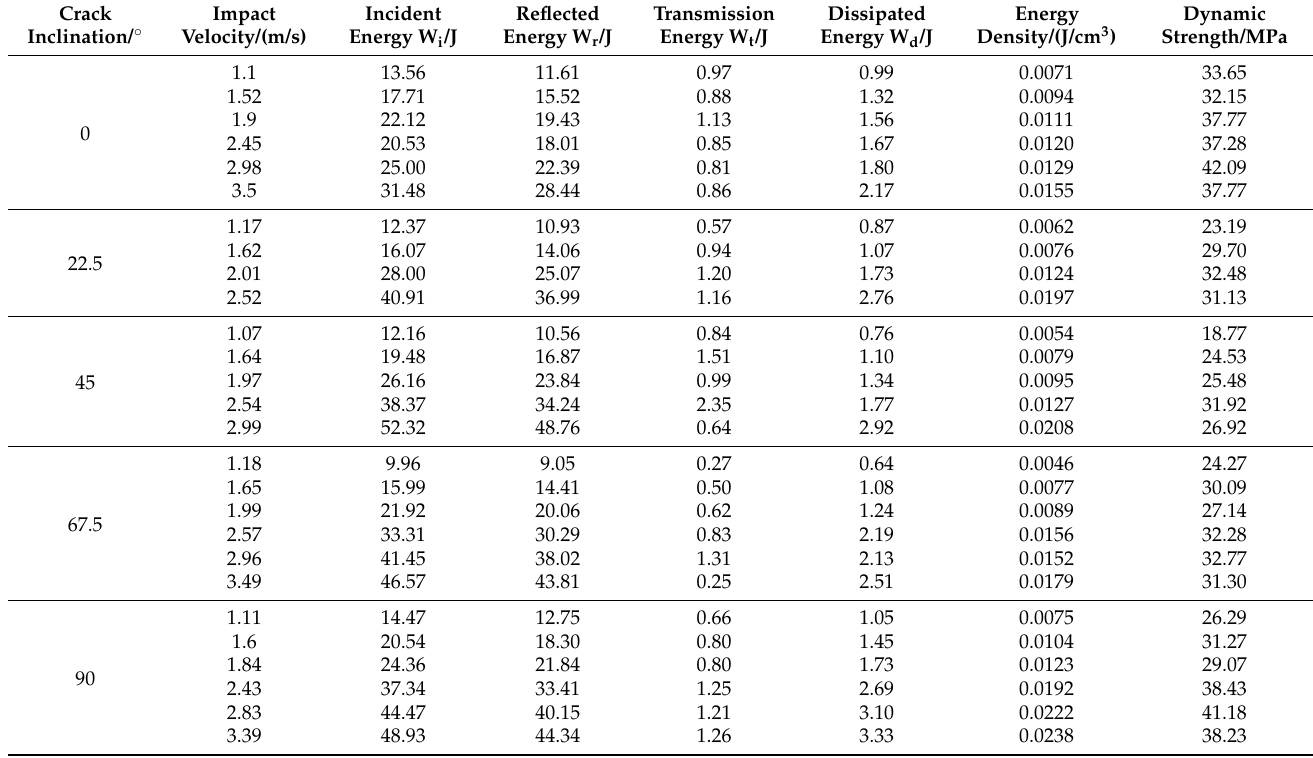
Table 1. Calculation result of dynamic impact energy of the